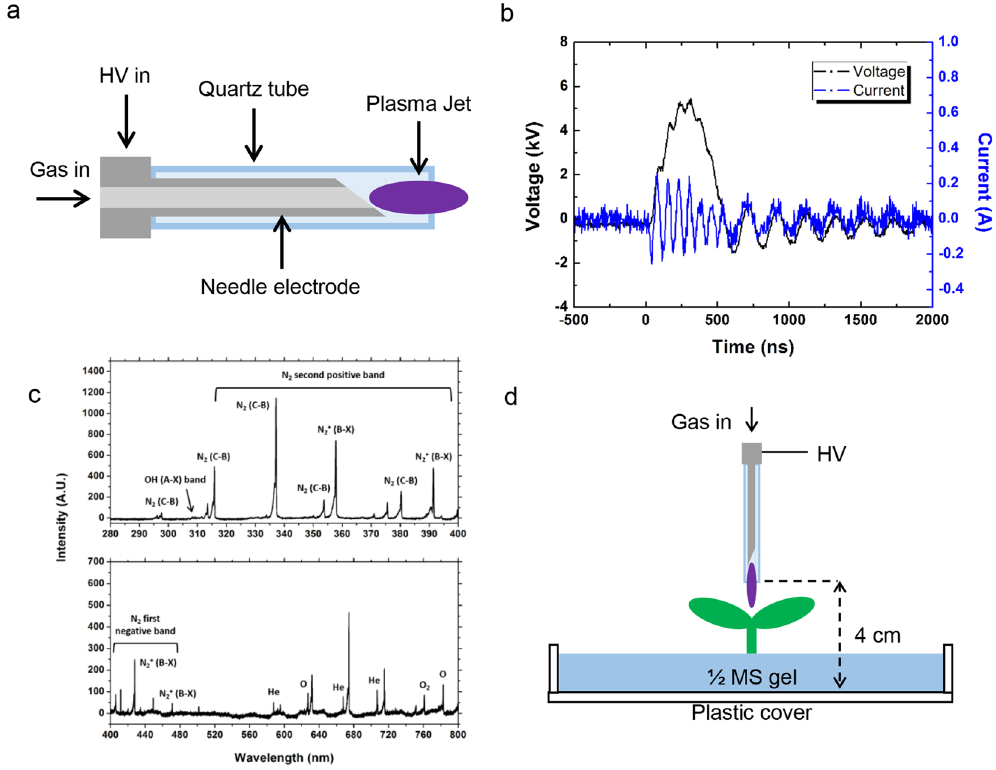
Figure 1. The experimental settings of the plasma treatment. ( a ) Structure of the plasma jet device ( b ) pulse voltage & discharge current signals of the plasma. ( c ) Emission spectra of the plasma. ( d ) Experimental setup of the plasma jet and the